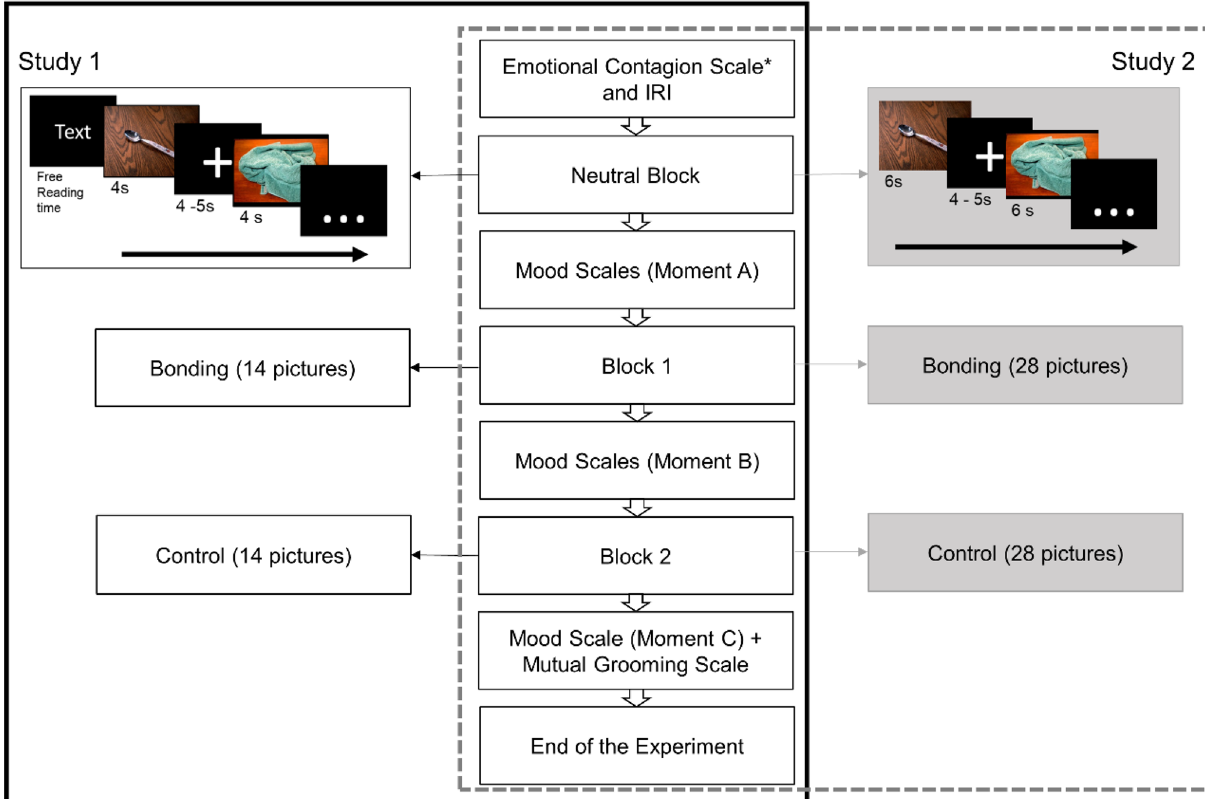
Figure 2. Sequence describing the order of the events throughout the experiment. Note This flowchart presents the sequence of the procedures for study 1 (left, black border) and study 2 (right, gray dotted border). Participants completed the empathy scales followed by viewing neutral pictures (training block). Then, mood scales were filled out (affiliative state and altruistic behavior, moment A ). In study 1, half of the participants read a priming text (i) before viewing bonding block and control block subsequently (14 pictures each), while the other half read a priming text (ii) before viewing the control block and bonding block subsequently (14 pictures each). In study 2, participants viewed 28 bonding pictures (block 1) and 28 control pictures (block 2) without reading a priming text. In both studies, participants completed the mood scales (moment B ) between blocks 1 and 2, as well as immediately after block 2 (moment C ). Finally, participants completed the Mutual Grooming Scale and the experiment was concluded. All pictures were exhibited for 4 s in study 1 and for 6 s in study 2, and pictures were followed by a black screen with a fixation cross ranging from 4 to 5 s in both studies. *Emotional Contagion Scale was used only in study paper towel for electrode placement. Silver chloride (Ag–AgCl) 4-mm electrodes were used to record the EMG activity of the corrugator supercilii and zygomaticus major muscles. Electrodes were placed at the left side of the face, two for each muscle. The ground electrode was placed in the left lateral malleolus. The positioning of the electrodes followed Fridlund and Cacioppo’s 21 method. Participants were informed that all instructions regarding the experiment would appear on the screen. They were asked to read the texts and observe the pictures attentively. The priming texts that contextualized the pictures were shown with free reading time. For the training block, a priming text was presented followed by four IAPS neutral pictures, each remaining on the screen for 4 s and were separated by a black screen with a central fixation cross lasting randomly between 4 and 5 s. This block was not used for the EMG analysis. After this moment, participants filled out the mood state scales (Fig. 2, moment A: Altruistic Behavior and Affiliative State). The experiment itself consisted of two blocks of emotional pictures (bonding and control), each preceded by a priming text to contextualize the pictures, with free reading time. The blocks’ presentation order (bonding/ control or control/bonding) was balanced among the participants. Fourteen pictures (bonding or control) were displayed for 4 s each, separated by a black screen with a fixation cross that lasted randomly for 4 to 5 s. Figure 2 displays the sequence of the events throughout the experiment. Each block duration varied between 112 s (1 min and 52 s) and 140 s (2 min and 20 s). After the first block, participants completed the mood state scales (Fig. 2, moment B: Altruistic Behavior and Affiliative State). Then, the experiment resumed with the second block of text and pictures, following the experimental sequence above. Participants then completed the mood state scales (Fig. 2, moment C: Altruistic Behavior and Affiliative State) and Mutual Grooming Scale. Finally, the electrodes were removed, and the par- ticipants were thanked and debriefed.